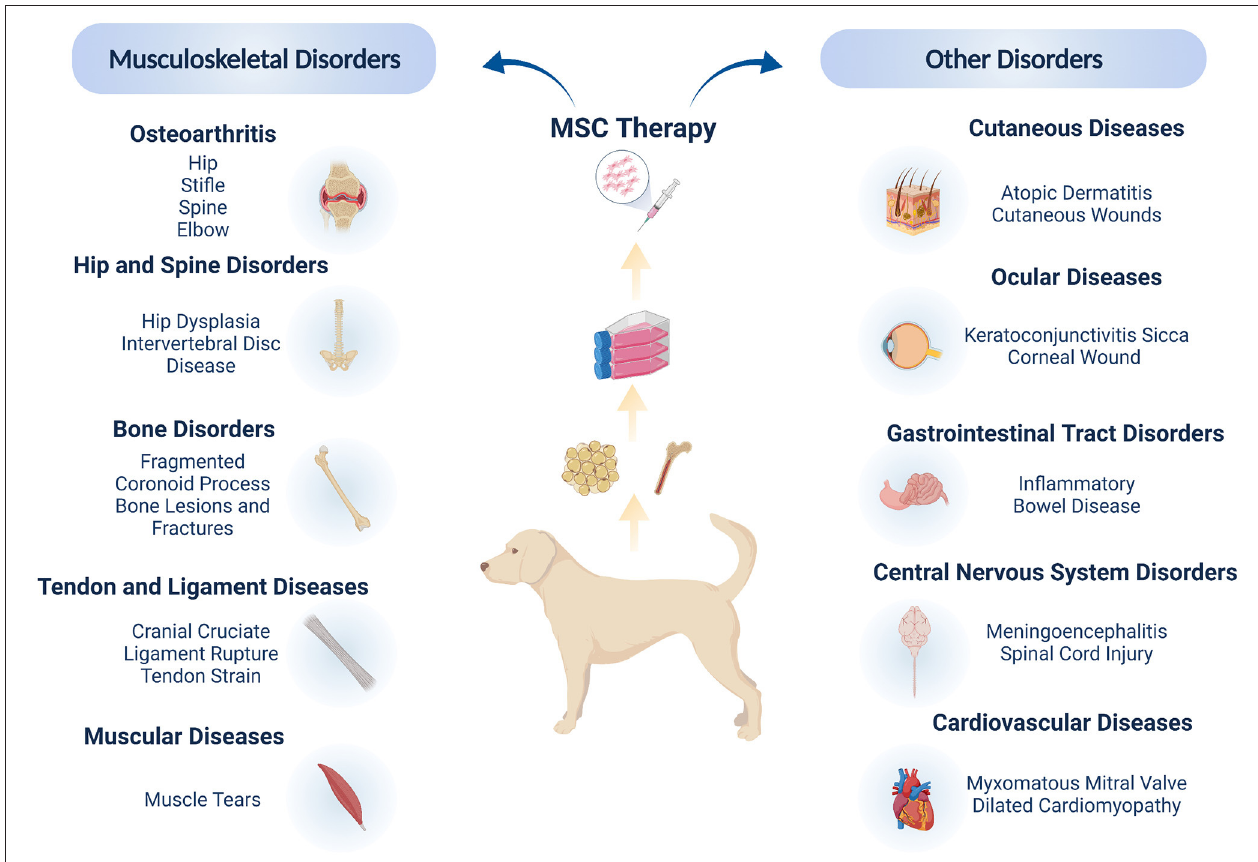
FIGURE 2 | Mesenchymal stromal cells in canine clinical studies. The majority of clinical applications address orthopedic and musculo-skeletal disorders, due to the high incidence of these conditions in dogs coupled with the ease of local administration of MSCs. Clinical trials have also highlighted the local and systemic applications of MSCs for other soft tissue conditions, showing the wide potential of MSC therapies in canine patients. Figure created with BioRender.com.